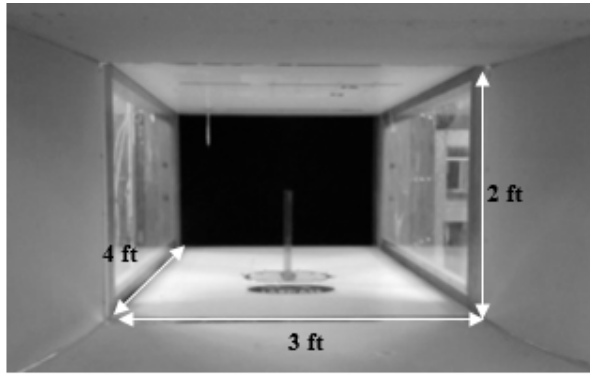
Figure 14. Dimension of the test chamber of the wind tunnel.